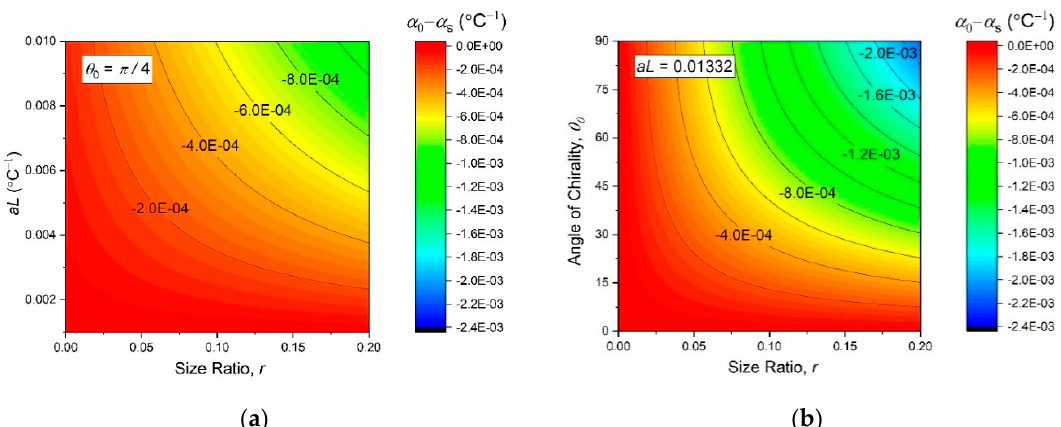
Figure 7. Contour plots of the initial thermal expansivity (13), as function of the independent design parameters ( θ 0 , r , and aL ).